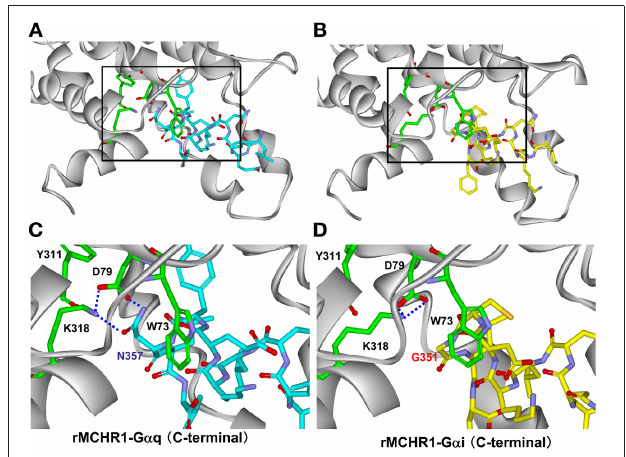
FIGURE 7 | Structural analysis of critical amino acids in a proposed model of rat MCHR1 mutant F318K with G α q or G α i proteins. Homology model of rat MCHR1 mutant F318K was constructed using the crystal structure of rhodopsin E113Q mutant in complex with the C-terminal tail of transducin (PDB ID 2X72). Amino acid residues involved in coupling to G α q or G α i proteins in intracellular loop 1 (i1) and K318 in helix 8 are shown. (A) The model structure of MCHR1(F318K)-G α q C-terminal tail. The area demarcated by the square is magnified below in panel (C) . (B) The model structure of MCHR1(F318K)-G α i C-terminal tail. The area demarcated by the square is magnified below in panel (D) . (C) Positions of Lys318, Tyr311, Trp73, and Asp79 residues and their position relative to Asn357 of G α q . This model depicts the hydrogen bond network between Lys318 and Asp79 in the receptor and Asn357 in G α q C-terminal tail. Note that interactions between Trp73 in i1 loop and Asn357 in the G protein C-terminal tail. Green, red, and blue areas indicate carbon, oxygen and nitrogen atoms, respectively, within the key residues of the receptor. Carbon atoms in the G α q protein are colored cyan. (D) Magnified view of Lys318, Tyr311, Trp73, and Asp79 residues in the receptor and their position relative to Gly351 of G α i . Intramolecular hydrogen interactions predicted between Lys318 and Asp79 in the receptor are shown. Carbon atoms in the G α i protein are colored